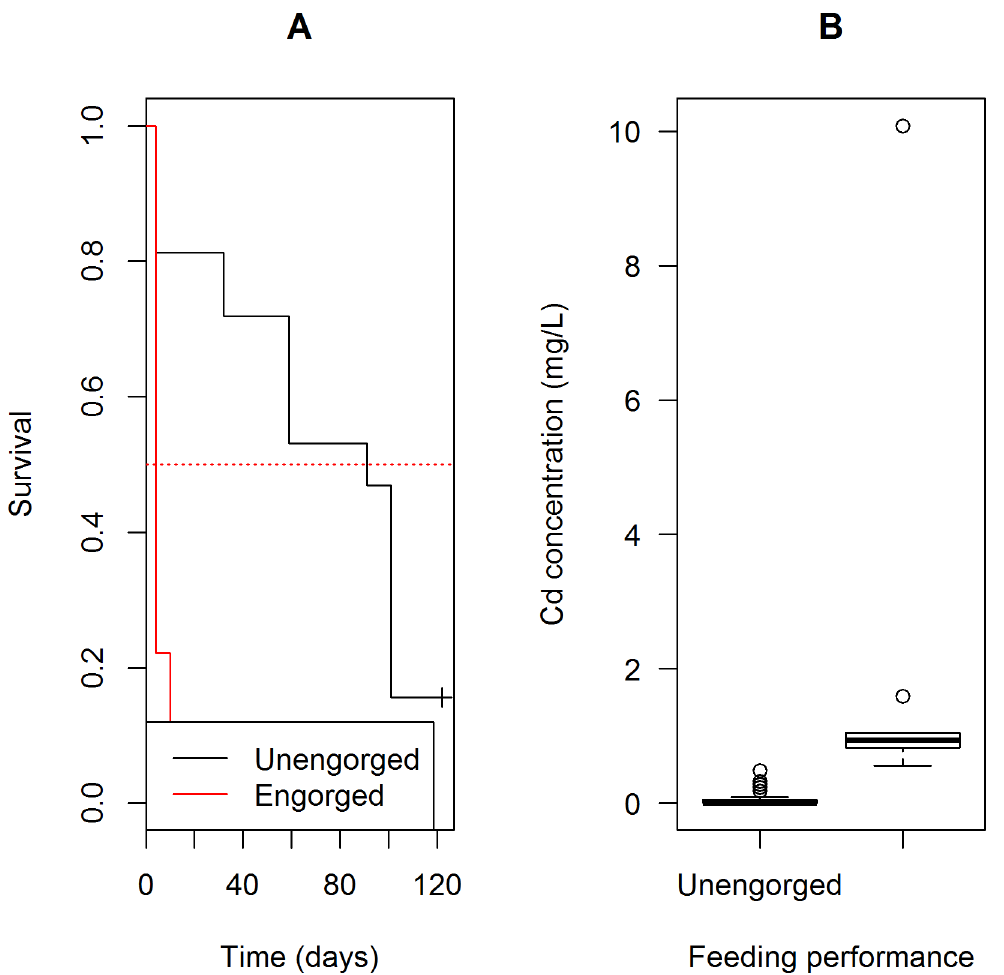
Fig 6. Survival of Cd-marked Rhodnius nasutus according to feeding performance (A) and Cd concentration in engorged versus unengorged insects (B) .